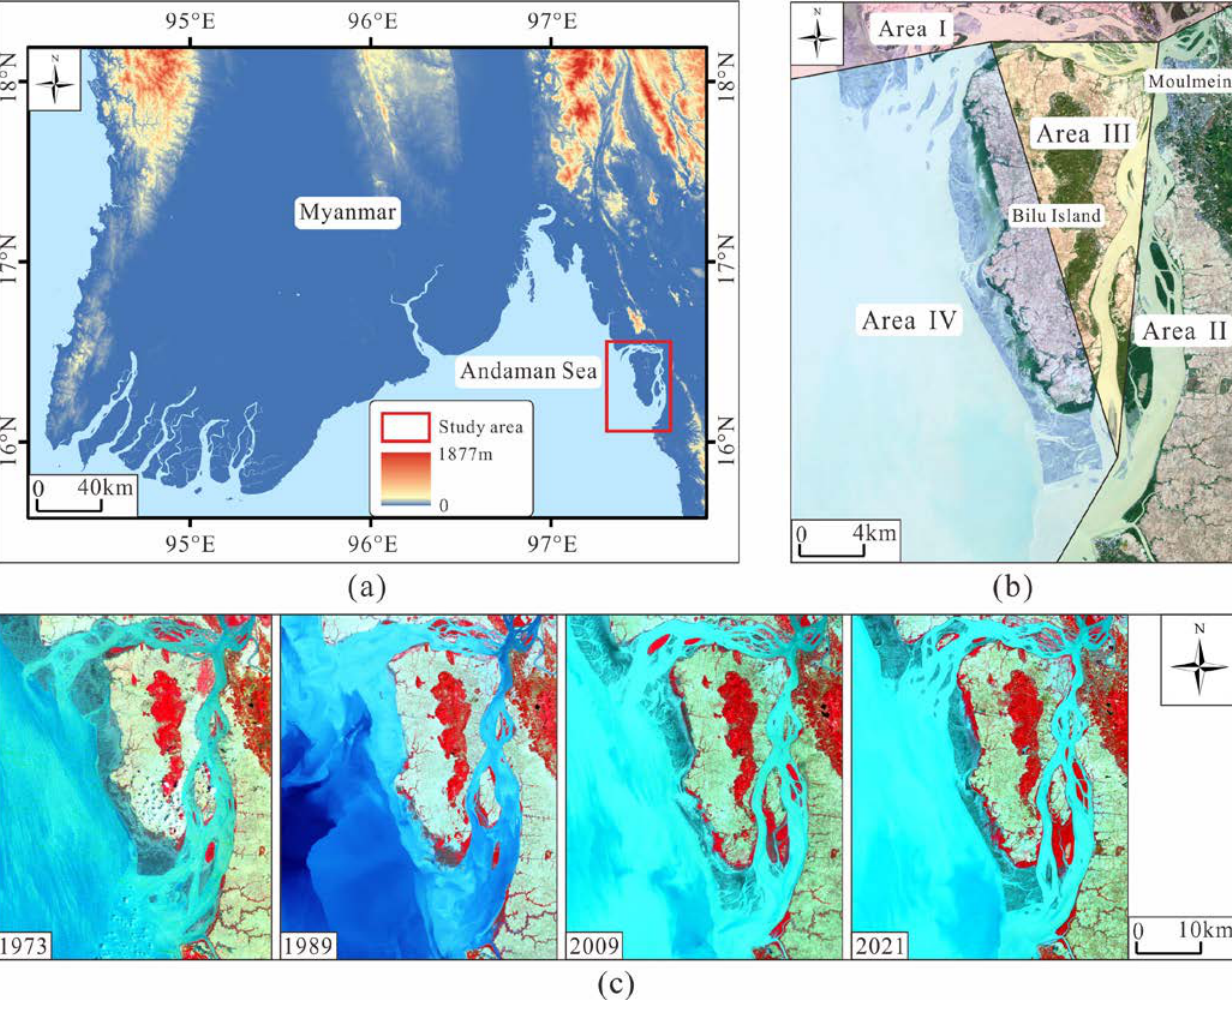
Figure 1. Location of the Salween River Delta with the red frame ( a ), division of the study area ( b ), and multi-spectral clear-sky remote sensing images of Landsat series data ( c ).